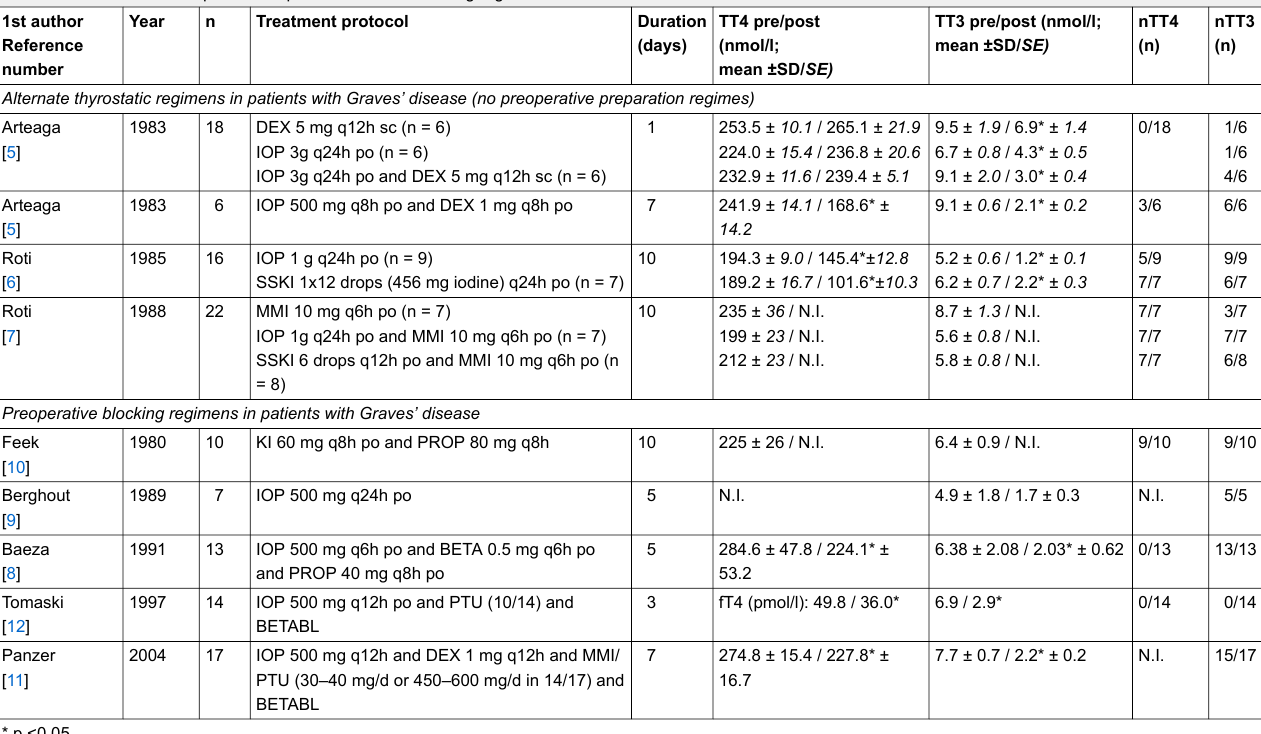
Table 3: An overview over previous reports of different blocking